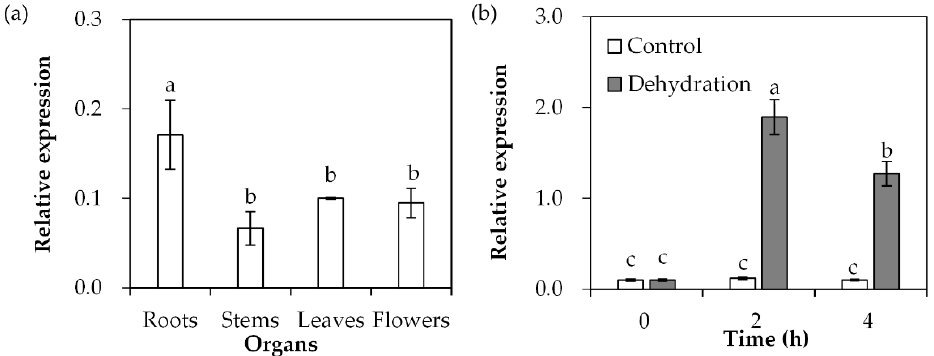
Figure 3. Analysis of SgDREB2C transcript in different organs and in response to dehydration treatment. Roots, stems and leaves were sampled from 3-week-old S. guianensis seedlings ( a ). The leaves from 3-week-old seedlings were placed in a hood for dehydration treatment to isolate total RNA, which was used to determine the relative expression of SgDREB2C using qPCR ( b ), while ACTIN was used as reference gene. Means of three replicates and standard errors are presented; the same letter above the column indicates no significant difference at p <